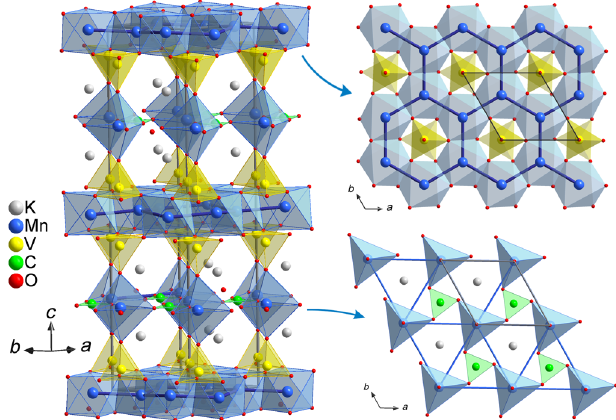
FIG. 2. Polyhedral view of K 2 Mn 3 ð VO 4 Þ 2 CO 3 crystal struc- ture. The structure consists of alternate stacking of two types of layered subsystems: a honeycomb layer made of edge-sharing MnO 6 octahedra and a triangular layer made of MnO 5 trigonal bipyramids linked by CO 3 triangles. Projections along the c axis of the two distinct layers are shown in the right